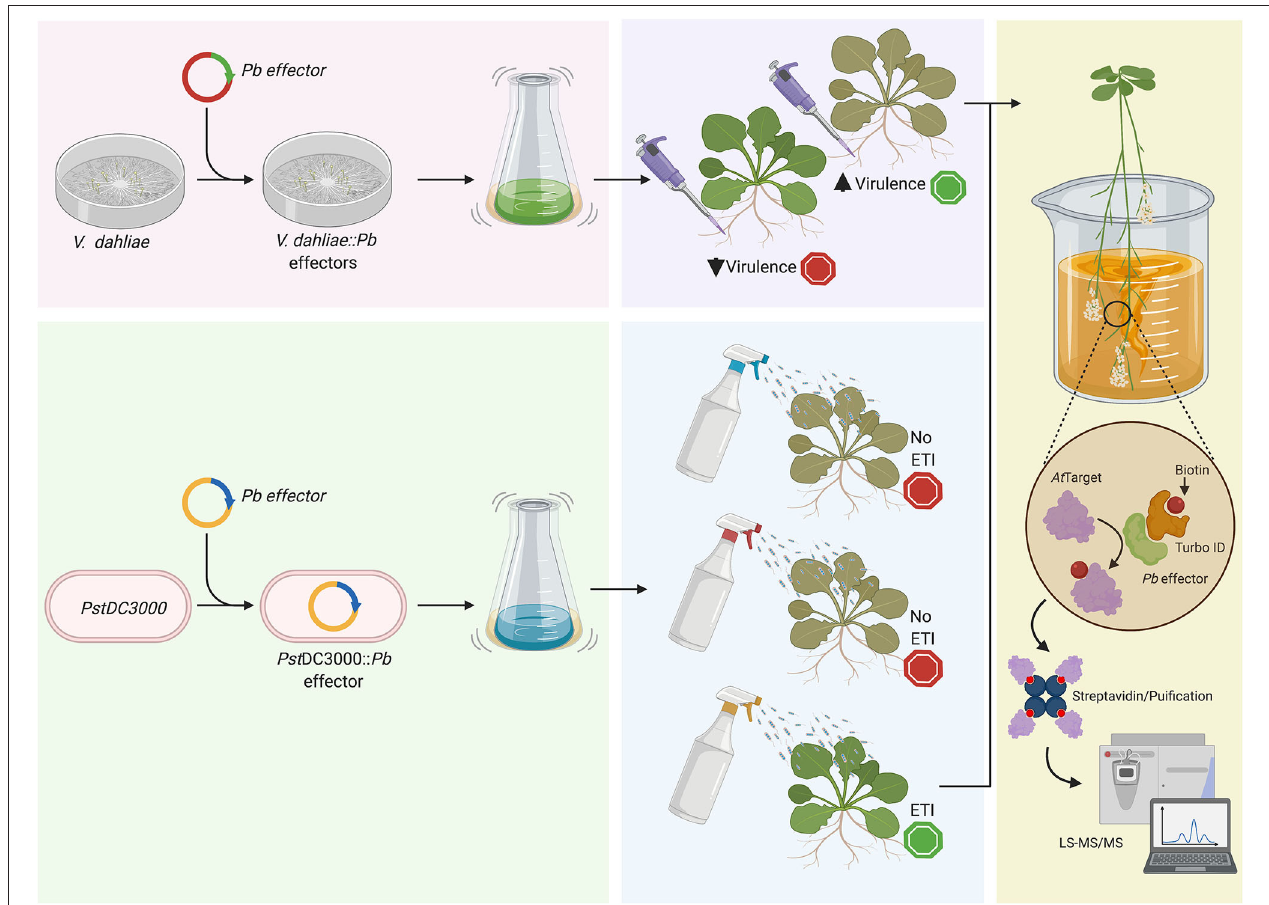
FIGURE 1 | Schematic representation of the use of a cultured surrogate plant pathogen to study and characterized P. brassicae candidate effectors. Here we proposed the use of ( i ) V. dahliae to, for example, complement deleterious mutations like the case discussed in the main text about the chitin-binding effectors, and ( ii ) P. syringae pv. tomato ( Pst DC3000), which can be used to screen effectors eliciting effector-triggered immunity. After the initial step selecting candidate effectors with a role on pathogenicity through the assessment of foliar symptomatology, we could identify the target in the plant host using a protein-protein approach like BioID as previously described Khan et al. (2018). Created with